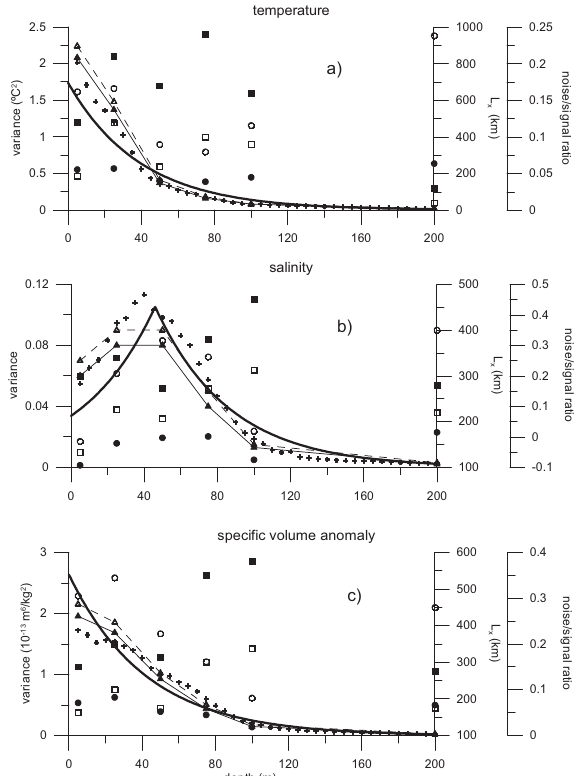
F IG . 4. – Variance obtained for different depths (5, 25, 50, 75, 100 and 200 db): We obtained the covariance as a function of the dis- tance (in the same way that we did for correlation in Fig. 3) and then we fit both a gaussian and an exponential function( ). σ 2 Triangles represent the parameter of the fit σ 2 for the different depths analysed. The same fit was applied to the correlation func- tion and from it we obtained R (see the text). Squares are the noise 0 to signal ratio for each depth, calculated from R , and the decay 0 length scale is represented by circles. Filled symbols correspond to the gaussian fit and open symbols to the exponential one. The thick solid line is the theoretical depth dependence of the variance pre- sented in Section 4.2, and crosses represent the variance as a func- tion of depth obtained from the covariance estimation for a fixed station and different depths and then setting z =z (see text, Section 1 2 4.3). Panels a, b and c show the same calculations for temperature, salinity and svan respectively.